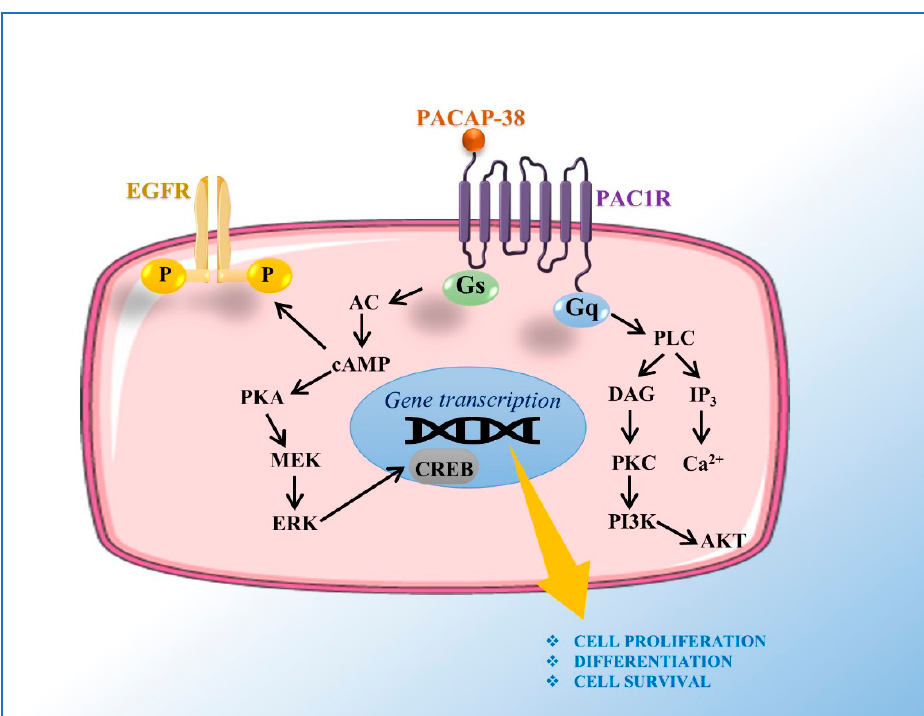
Figure 3. Signal transduction mechanism of PACAP receptor. The PAC1 receptor is able to engage Gs/Gq signaling pathways. PAC1 receptor mediated Gs activation stimulates AC via cAMP to promote MEK/ERK activation. The intracellular cAMP formation is also responsible of EGFR phosphorylation. PAC1 receptor mediated Gq activation stimulates PLC leading to DAG and IP3 activation. DAG activates PKC stimulating PI3k/Akt signaling pathway, whereas IP3 causes the Ca2+ release from endoplasmic reticulum. Both MAPK/ERK and PI3K/Akt pathways mediate cell proliferation, differentiation, and survival by inducing transcription of different genes, such as CREB. AC, adenylyl cyclase; cAMP, cyclic adenosine monophosphate; CREB, cAMP response element ‐ binding protein; DAG, diacylglycerol; EGFR, epidermal growth factor receptor; ERK, extracellular signal ‐ regulated kinase; IP3, inositol ‐ 1,4,5 ‐ triphosphate; MEK, mitogen ‐ activated protein kinase kinase; PACAP, pituitary adenylate cyclase ‐ activating polypeptide; PAC1R, PAC1 receptor; PI3K, phosphatidylinositol 3 kinase; PLC, phospholipase C; PKC, protein kinase C.